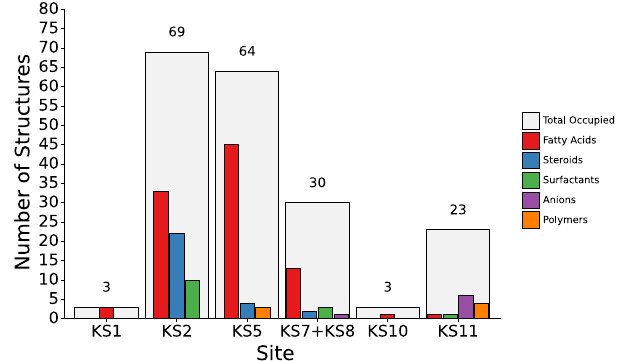
Fig. 5 Absolute number of observed instances of components other than synthetic ligands in the Known Sites (KS). Shown are the total number of structures in which at least one component was resolved in each site (light grey bars) and the respective numbers for surfactants (green), anions (purple), fatty acids (red), steroids (blue), and polymers (orange). Source data are provided as a source_data.xlsx